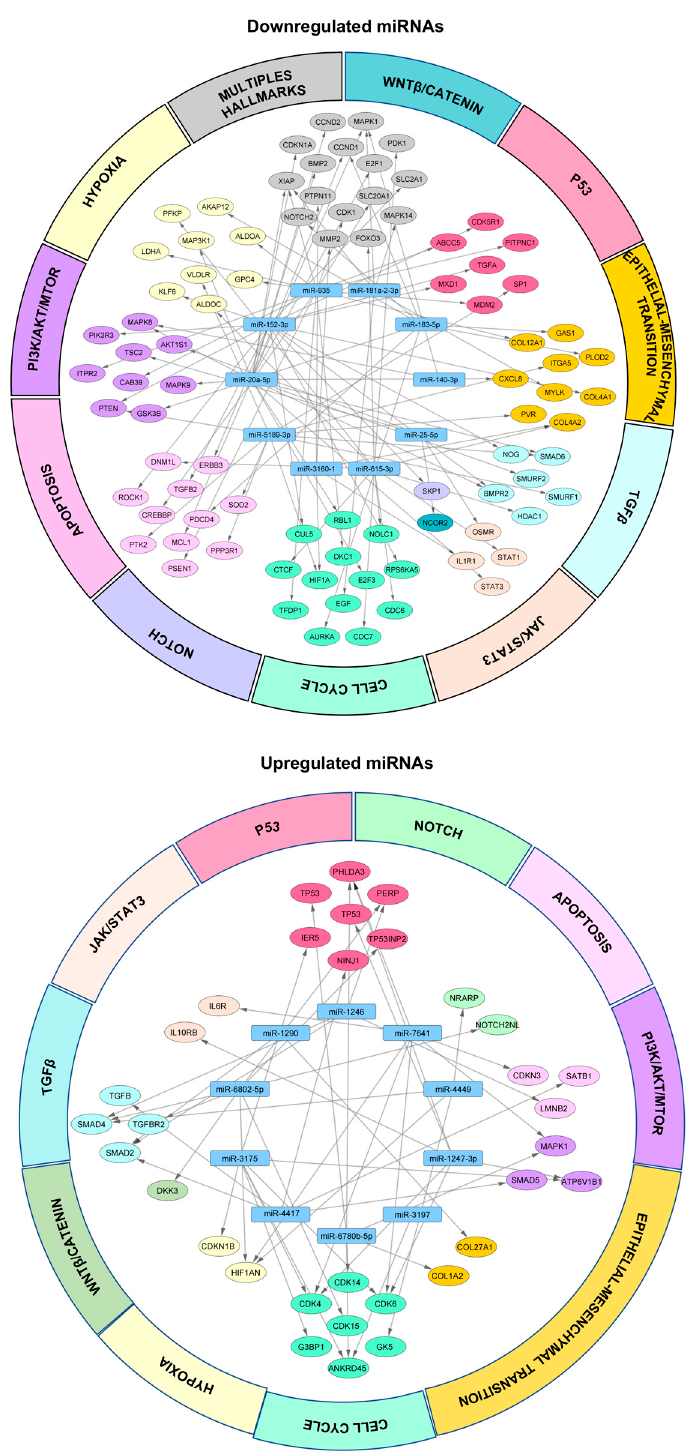
Figure 6. MiRNA/mRNA interaction networks of the 10 most deregulated miRNAs in 3D cell cultures. The graph shows the interaction network of the 10 most downregulated miRNAs in 3D organotypic cultures ( upper panel ) and the 10 most upregulated miRNAs ( bottom panel ) with their target mRNAs involved in hypoxia, Wnt/ β -catenin, cell cycle, apoptosis, TGF β , JAK/STAT3, NOTCH, P53, PI3K/AKT/mTOR, and epithelial–mesenchymal transition signaling pathways us- ing Cytoscape software. The blue rectangle indicates the nodes represented by miRNAs, and the different colored ovals corresponding to each signaling pathway indicate the target mRNAs of the corresponding